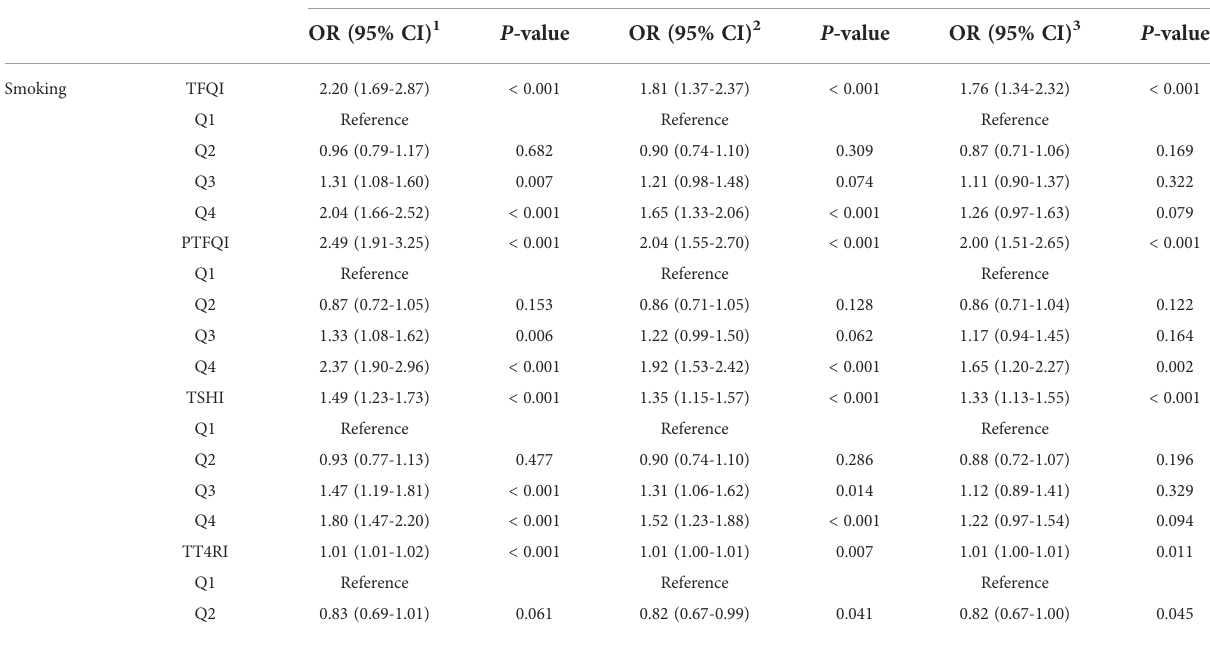
TABLE 5 Association between thyroid hormone sensitivity and carotid plaque according to smoking.